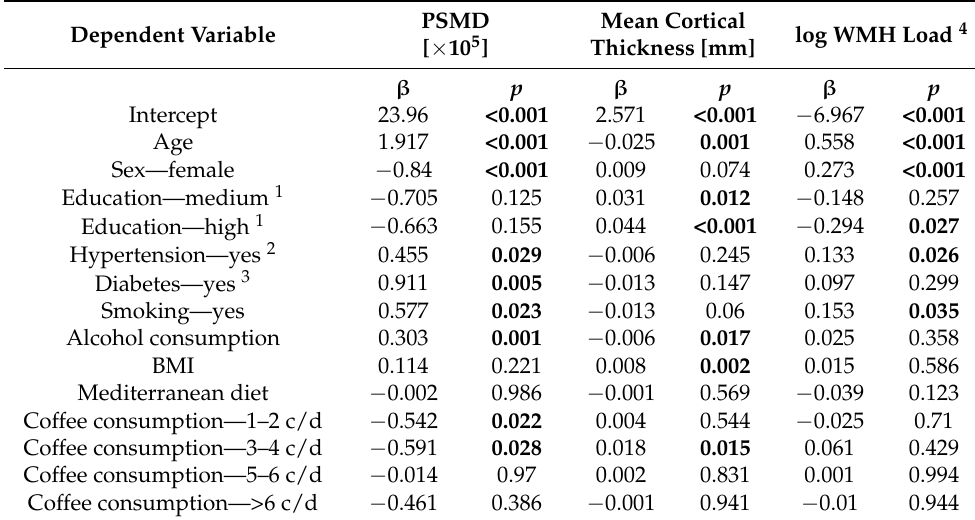
Table 2. Results of the linear regression models examining the association between coffee consump- tion and microstructural brain parameters. Dependent Variable